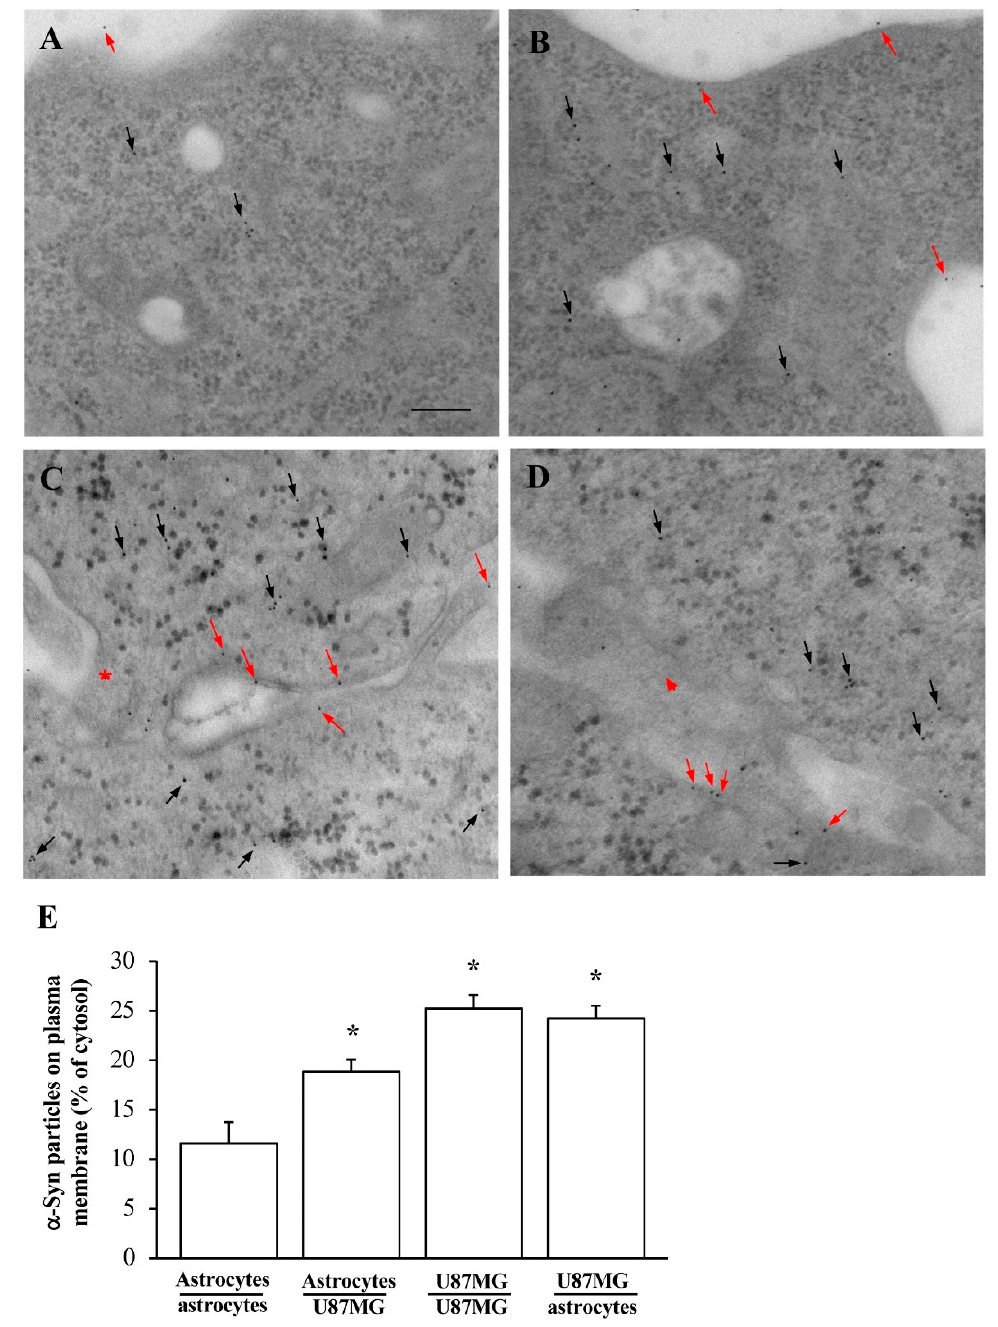
Figure 5. Increase and misplacement of α -syn in astrocytes exposed to GBM cells. Representative micrographs show astrocytes co-cultured with astrocytes ( A ); astrocytes co-cultured with GBM cells ( B ); GBM cells co-cultured with GBM cells ( C ), and GBM cells co-cultured with astrocytes ( D ). These representative micrographs show that plasma membrane of baseline astrocytes is quite plain. At this level, α -syn is scarcely present as shown by red arrows, while black arrows point cy- tosolic α -syn. In contrast, α -syn is often found at the plasma membrane when astrocytes are co- cultured with GBM cells ( B ) or within GBM cells in each conditions ( C , D ). In these cells α -syn is shown within cytoplasmic bridges (red asterisk) and/or in the narrow space between two cells (red arrowhead). It is remarkable that when astrocytes are co-cultured with GBM cells their plasma membranes are no longer plain, rather developing convolutions shaping bridges and tunneling analogous to GBM cells. Accordingly, α -syn is mostly placed at these membrane elongations. Graph ( E ) reports the percentage of α -syn immuno-gold particles counted at the plasma mem- brane compared with those measured in the cytosol. The amount of α -syn molecules placed at the